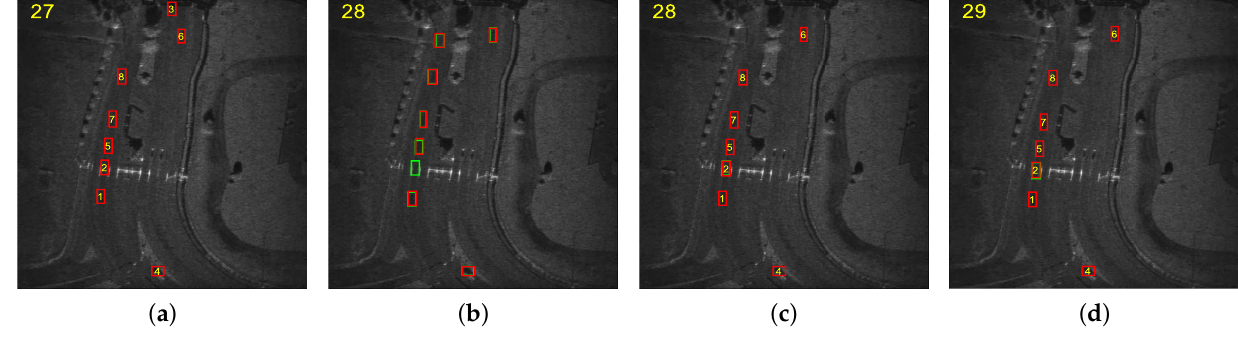
Figure 26. Tracking results of the proposed method when the target is obscured in only one frame. The green boxes denote the ground truths, and the red boxes denote detection or tracking results. ( a ) Tracking results at frame 27. ( b ) Detection results at frame 28. Target 2 is undetected due to the occlusion of the background clutter. ( c ) Tracking results at frame 28. Target 2 is tracked successfully. ( d ) Tracking results at frame 29. Target 2 is also tracked successfully.